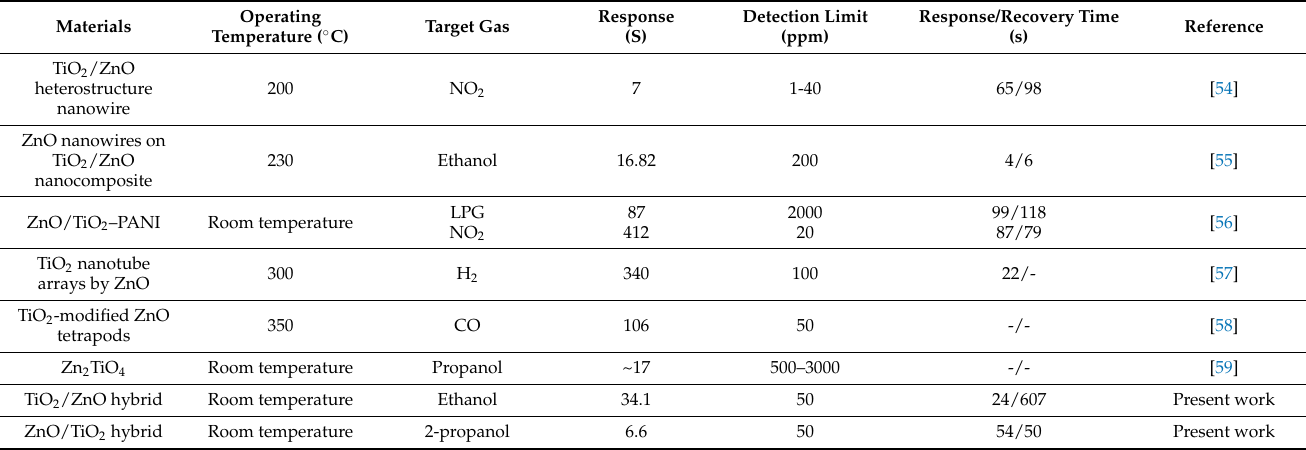
Table 1. Comparison with other TiO 2 -ZnO sensors previously reported in the